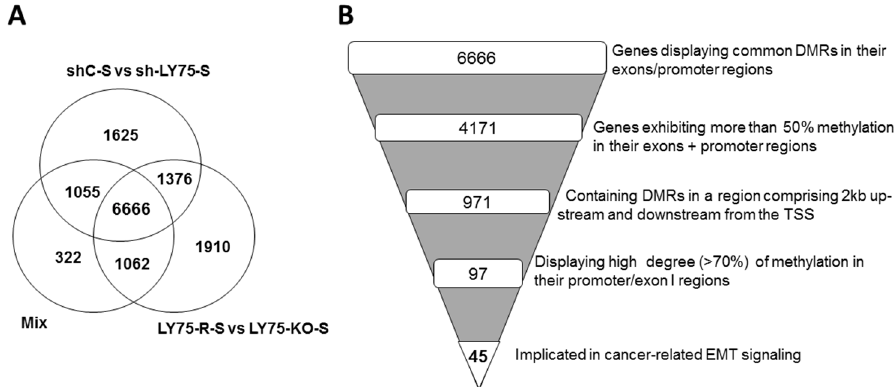
Figure 1. RRBS analysis of genes displaying common differentially methylated regions (DMRs) in their exons and promoter regions. ( A ) Venn diagram analysis of the three different comparison (M vs. E) experimental combinations used for RRBS analysis (see Table 1B for details); ( B ) A funnel plot indicating the selection criteria for the genes retained for further analyses, exhibiting a high degree of methylation in their promoter regions and implicated in cancer-related EMT signaling.